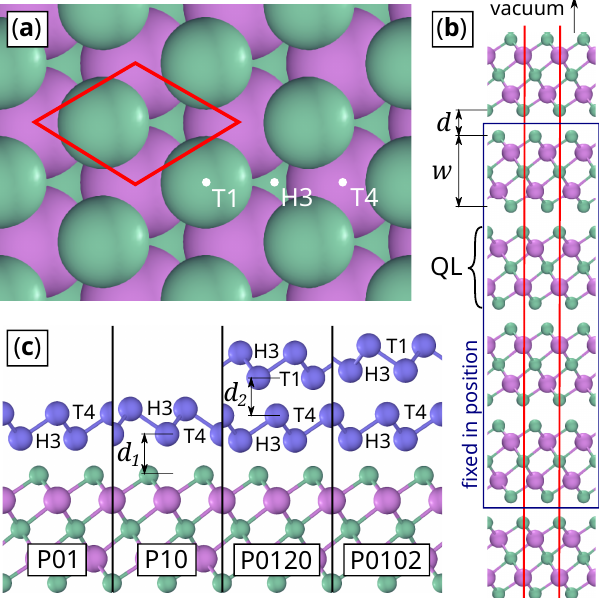
Figure 1. Sketch of the Bi 2 S 3 slab. Bi atoms are violet, Se atoms are green, Sb atoms are blue: ( a ) Top view with unit cell (red) and labels for symmetry positions (white). ( b ) Cross section with unit cell (red). The atoms in the blue box are fixed in position during relaxation. ( c ) Cross section of the two most stable 1BL-Sb@BS and 2BL-Sb@BS